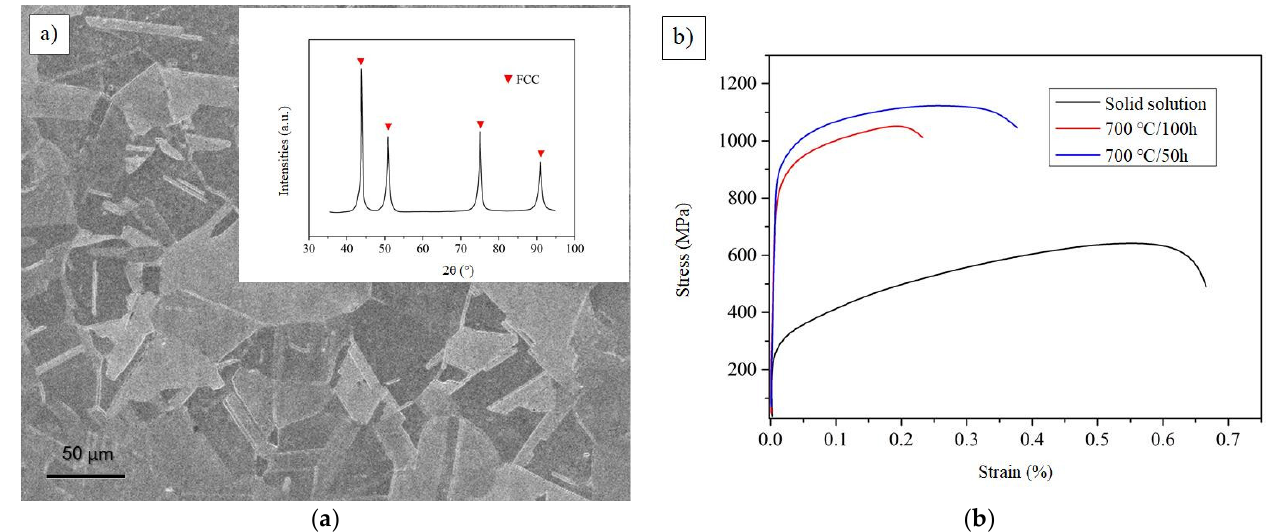
Figure 12. The SEM, XRD, and stress-strain curves of CoCrFeAlTa 0.16 . ( a ) The SEM and XRD images at 50 h annealing state; ( b ) The stress-strain curves of different heat treatment states.